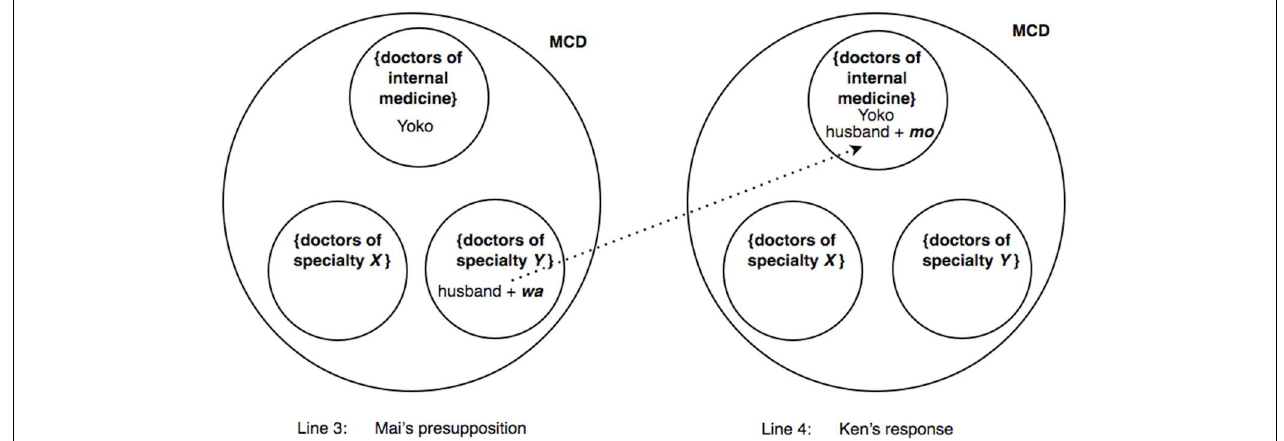
mo to place him back in {doctors of internal medicine} (right) . MCD = “types of medical doctors” = [{doctors of internal medicine}, {doctors of specialty Y }, {doctors of specialty X },...], where Y and X are unspecified. Only three of the many possible specialties have been represented in the